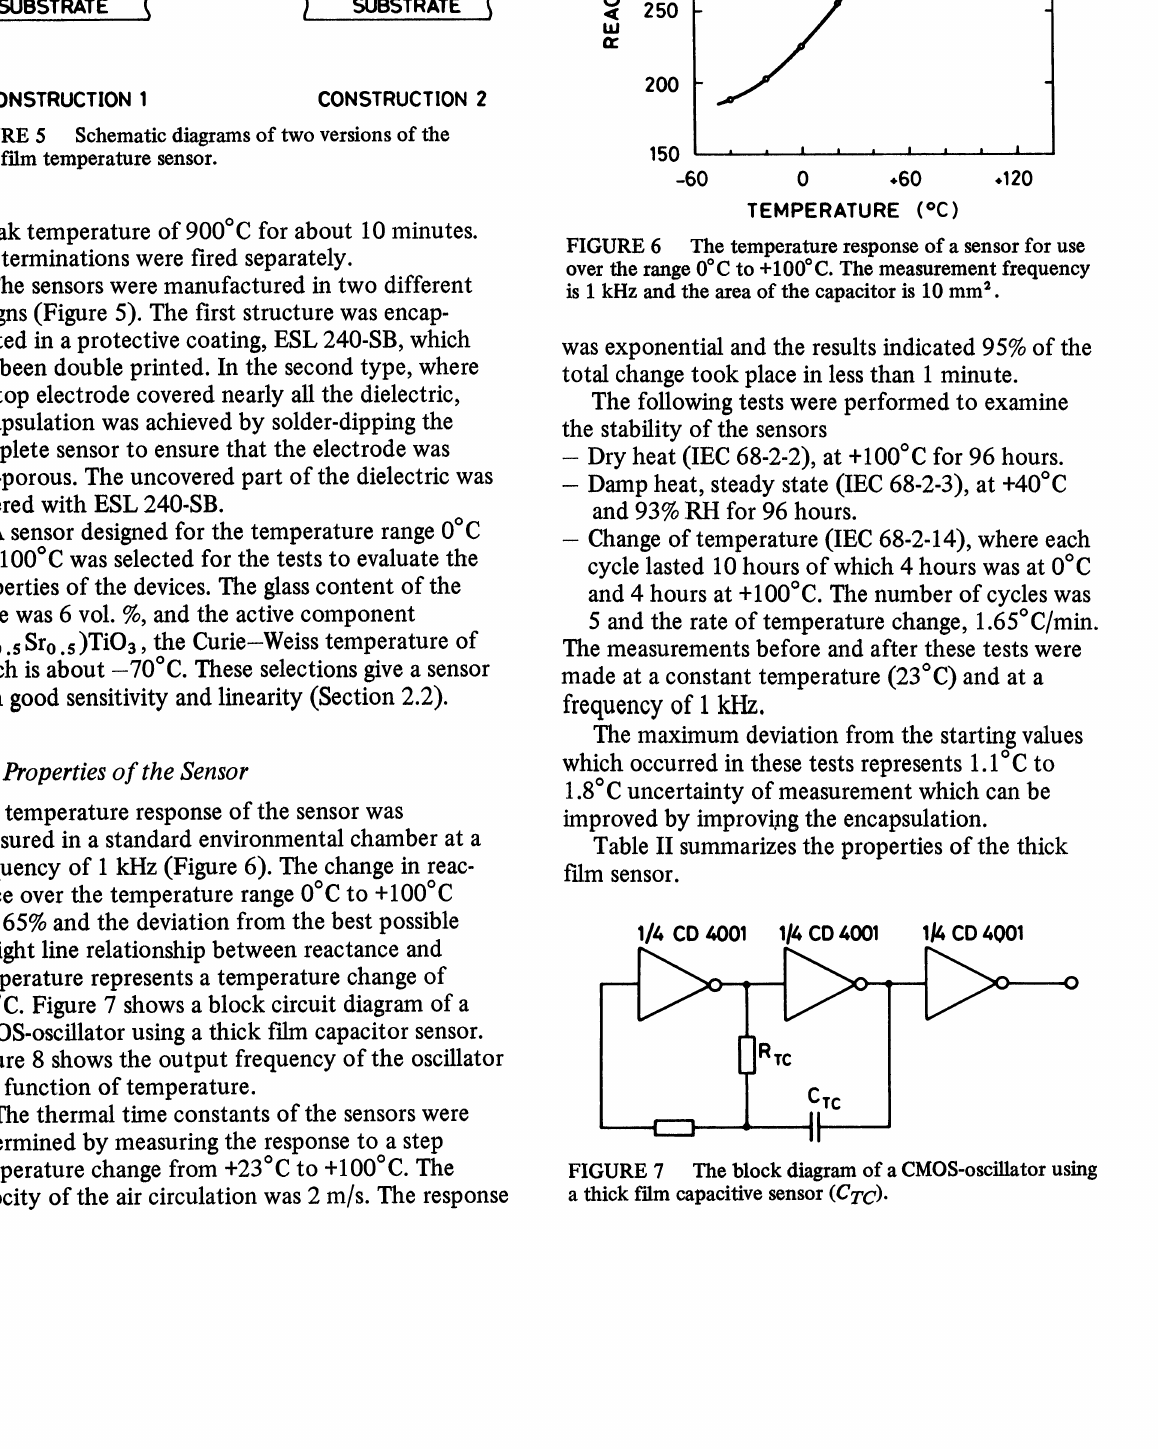
Schematic diagrams of two versions of the thick film temperature sensor. a peak temperature of 900C for about 10 minutes.